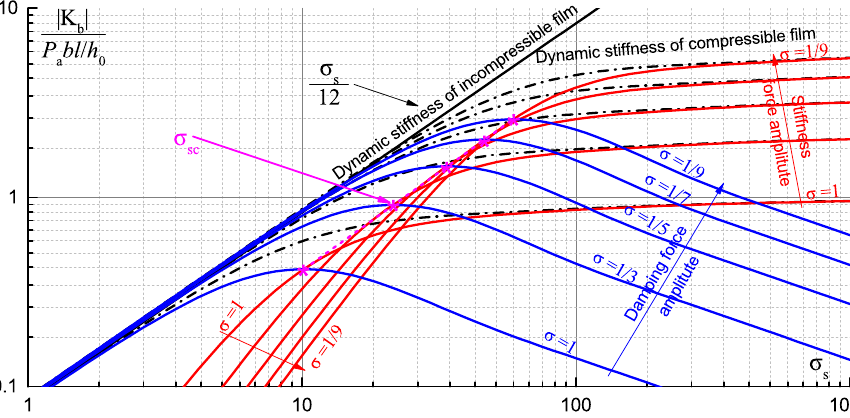
Figure 13. Dynamic stiffness modulus of the 1D parallel slider with supply